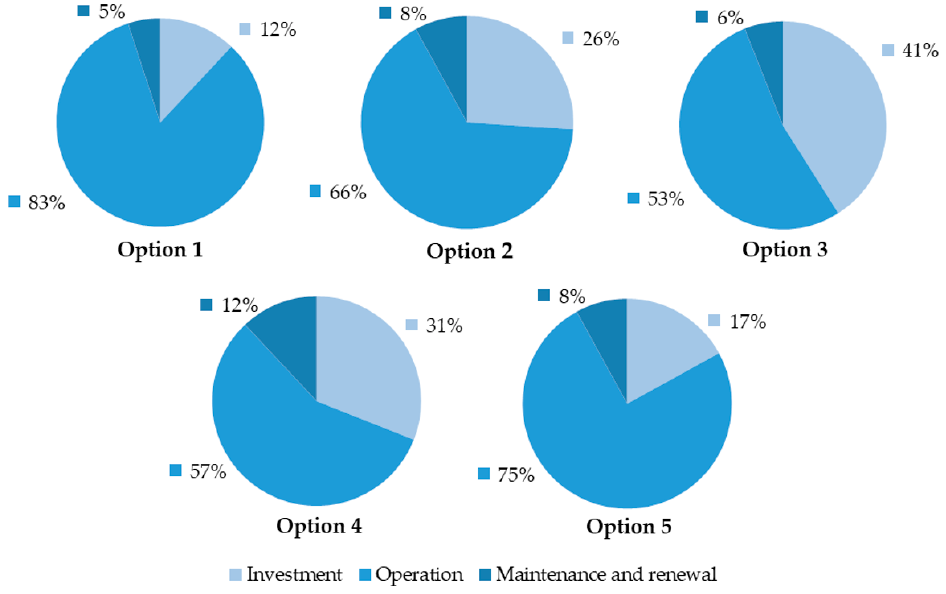
Figure 2. Comparison of the results of all options.